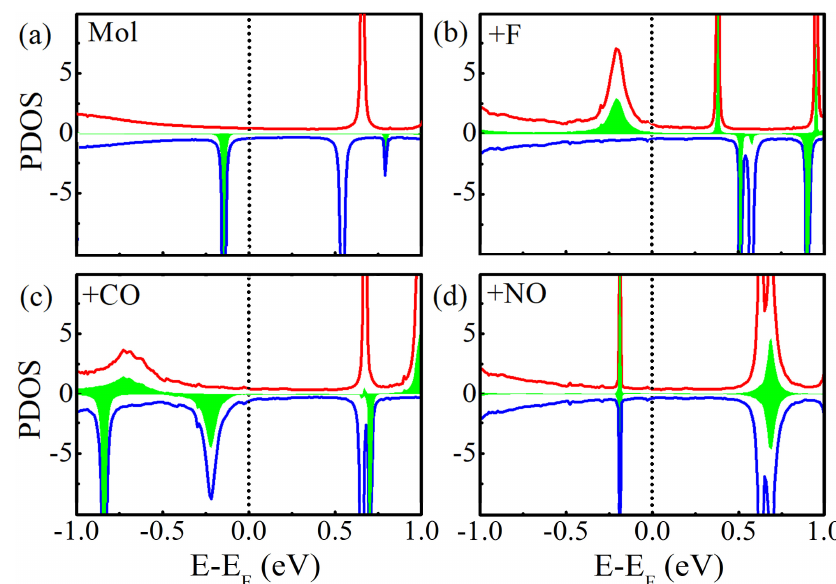
Figure 5. ( a ) The projected DOS of Mn-salophen molecule in junction without chemical adsorption, ( b – d ) for Mn-salophen with F, CO, and NO adsorptions. Here, the short-dotted vertical lines stand for the Fermi level for clarity, while the red and blue lines stand for the spin-up and spin-down electrons, respectively, and the PDOS of Mn cation is plotted with the filled regions with green